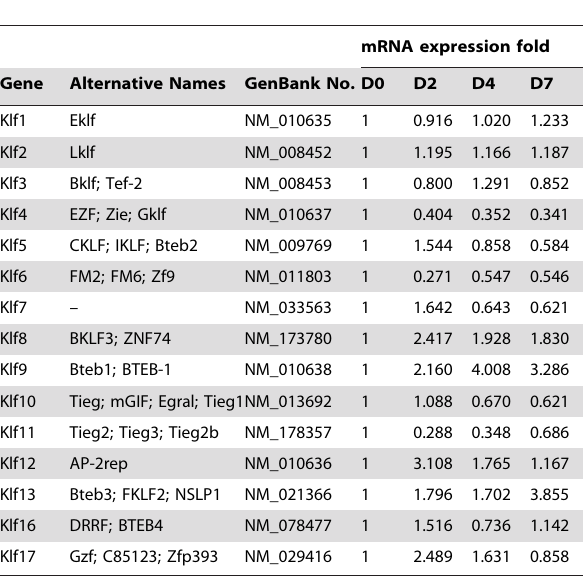
Table 1. Gene expression change of KLF family members during 3T3-L1 differentiation.